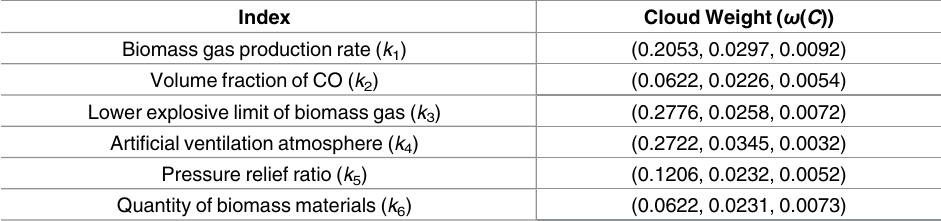
Table 4. Cloud weight of each index.